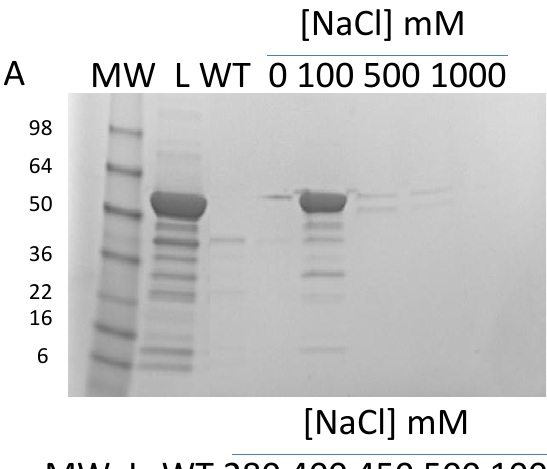
Figure 5. ( A ) SDS-PAGE of step gradient fractions from chromatography of rsAra h 1 on High-Q resin. “L” indicates the material loaded on the column. “WT” indicates the wash through material that didn’t bind the resin. ( B ) SDS-PAGE of step gradient fractions from chromatography of rsAra h 1 on High-S resin. “L” indicates the material loaded on the column. “WT” indicates the wash through material that didn’t bind the